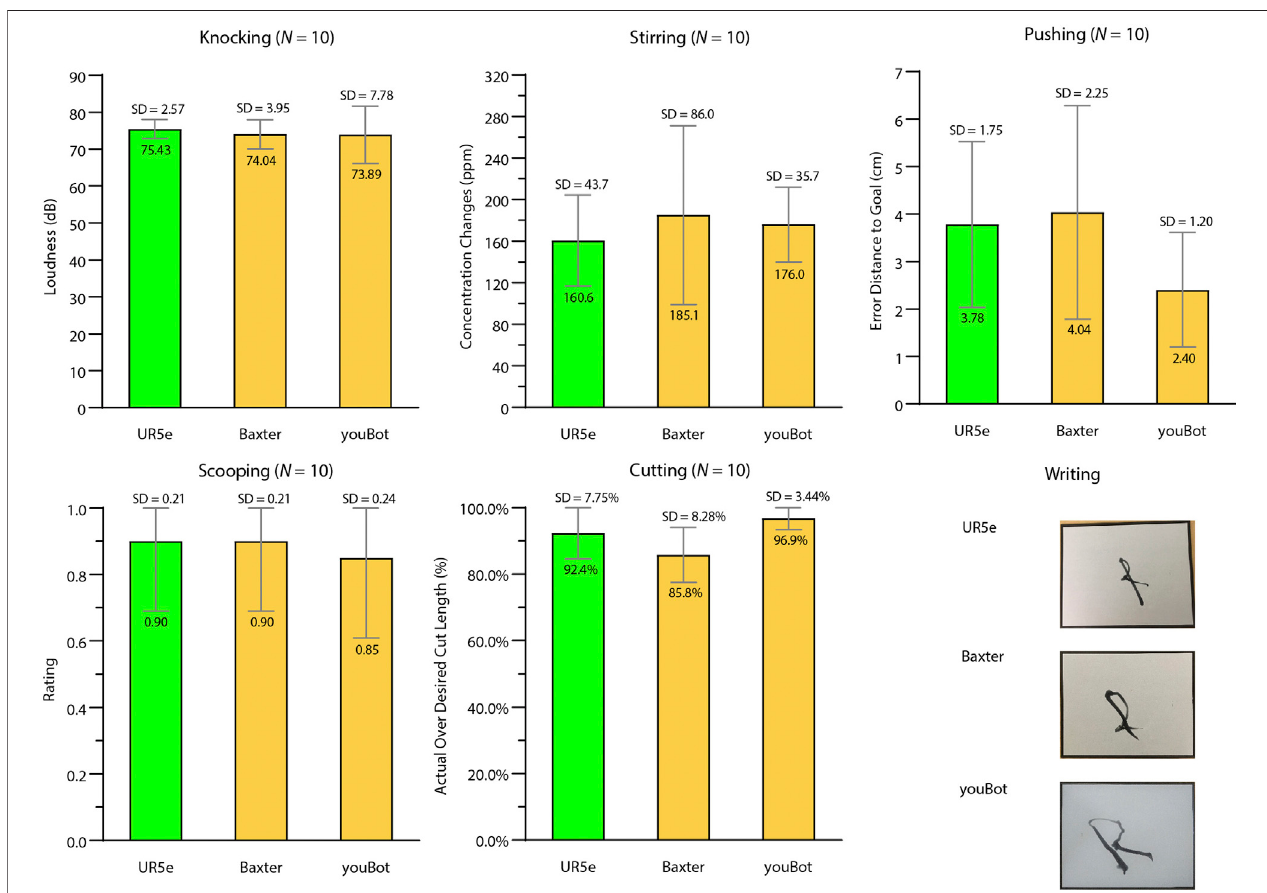
FIGURE11| Resultsoftool-use skillgeneralizationacrossrobot platforms (Star3). Thebar graphsincluderesults oftheUR5e (green), Baxter (yellow), and youBot (yellow) using the source tool/manipulandum combinations for knocking, stirring, pushing, scooping, and cutting. The pictures at the bottom right demonstrate different robots writing “ R ” with trained scale and